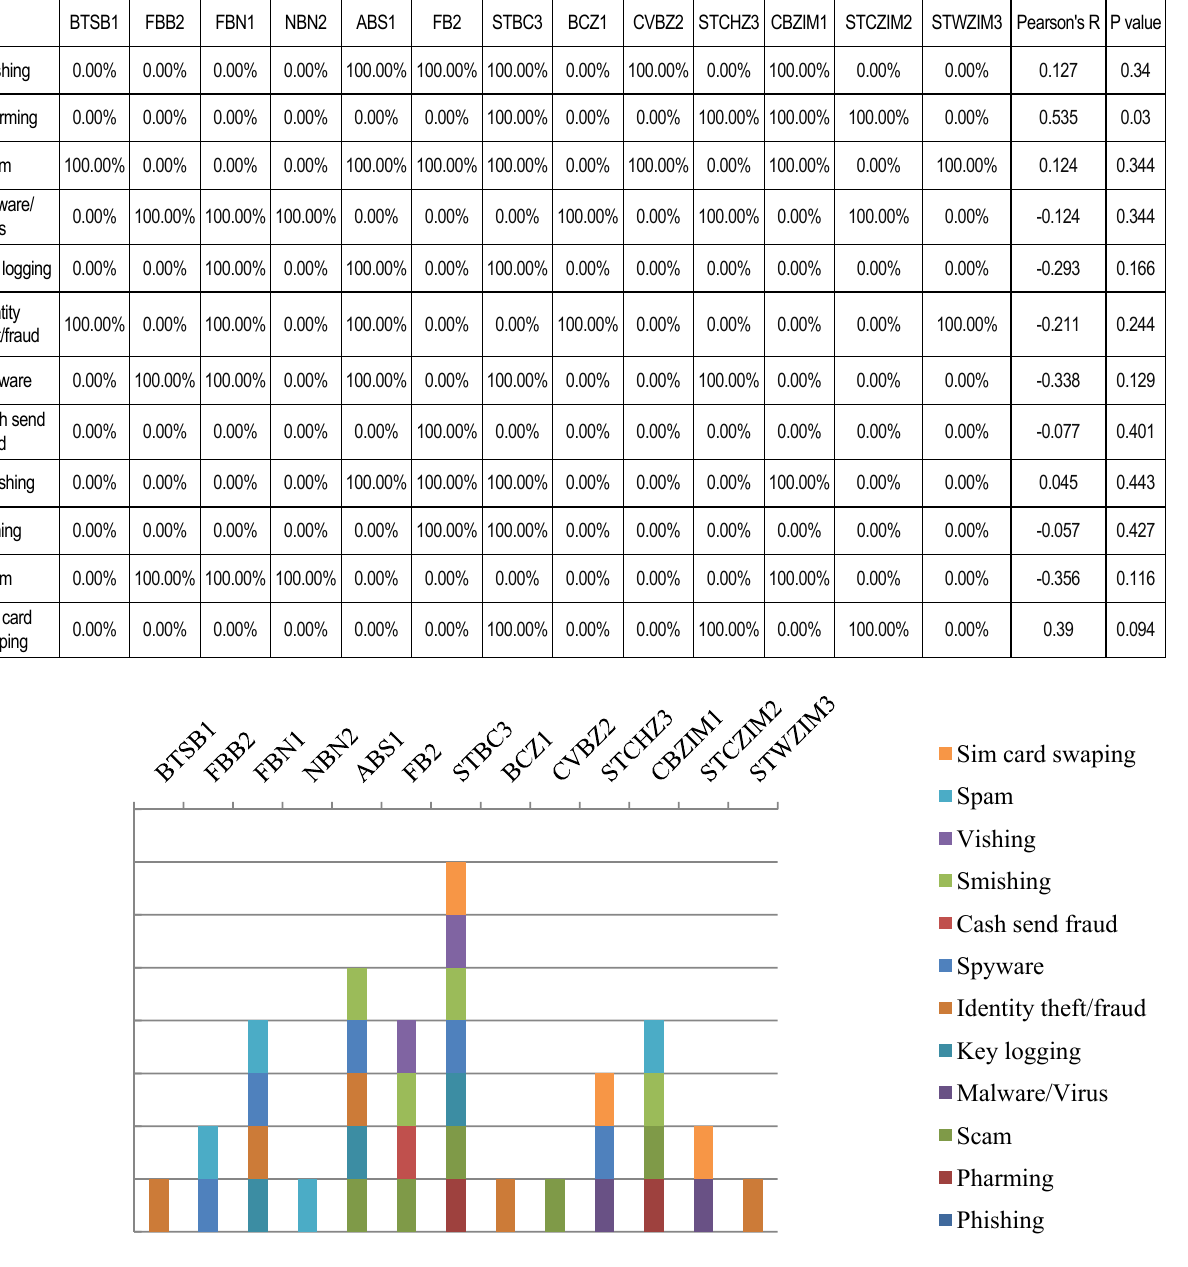
Table 3. Internet banking fraud awareness - crosstab matrix